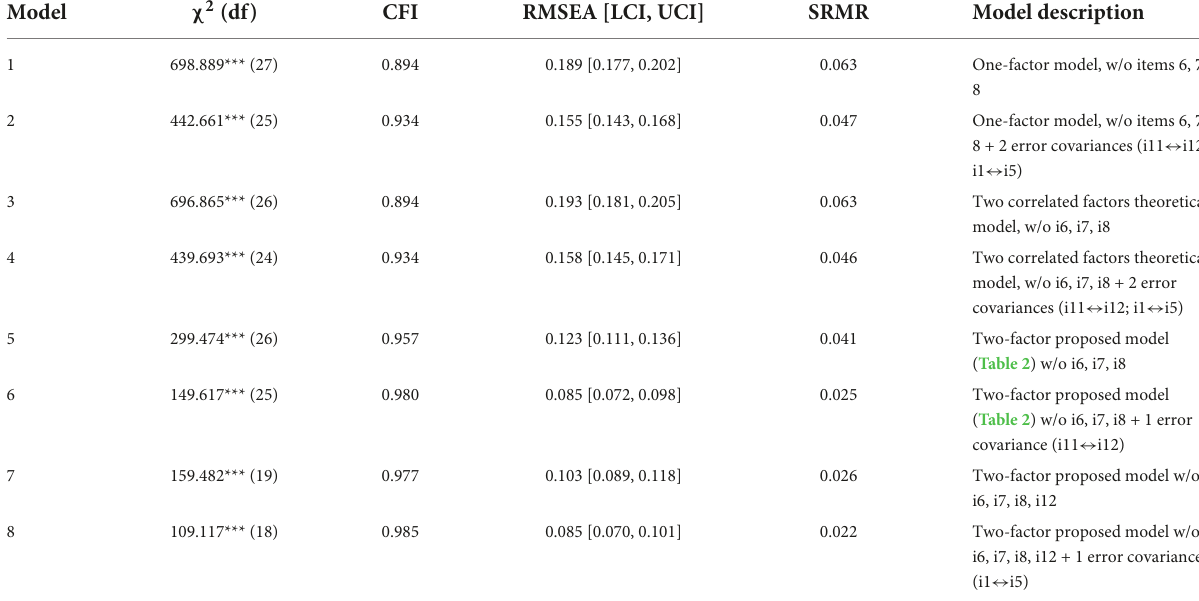
TABLE 3 Goodness-of-fit indices of alternative confirmatory factor analysis (CFA)